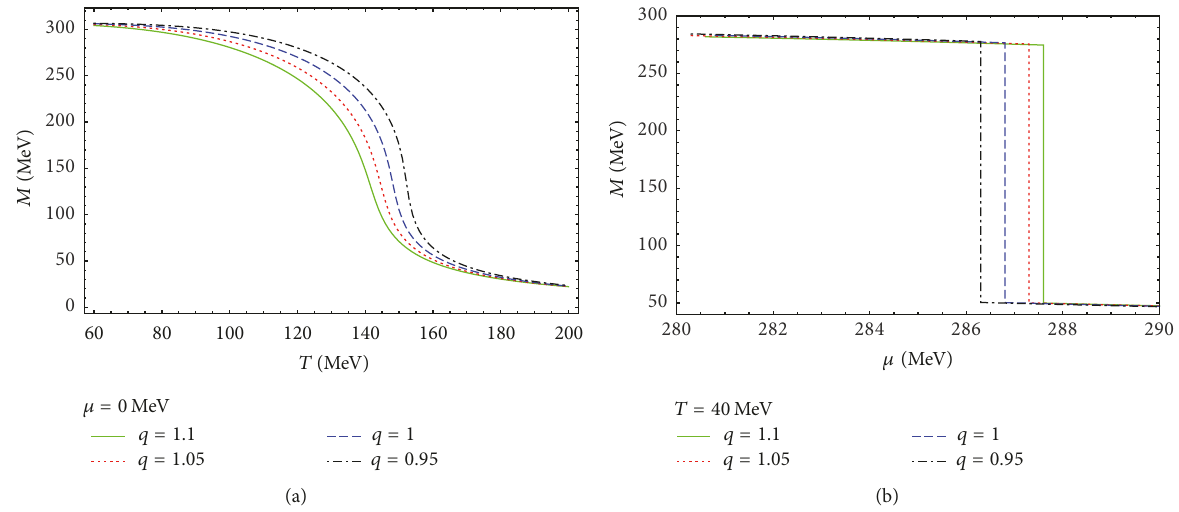
Figure 2: The constituent (anti)quark mass 𝑀 as functions of the temperature 𝑇 at 𝜇 = 0 (a) and the chemical potential 𝜇 at 𝑇 = 40 MeV (b) for different 𝑞 as follows: q = 1.1, q = 1.05, and q = 0.95 as well as q =